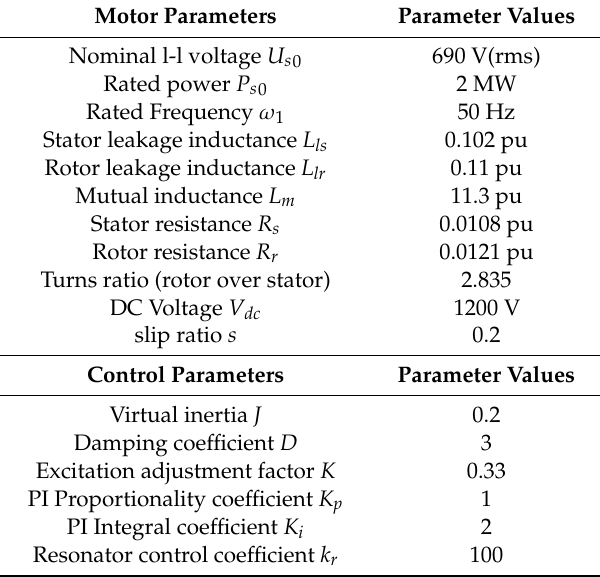
Table 1. System parameters of the doubly fed induction generator (DFIG) control